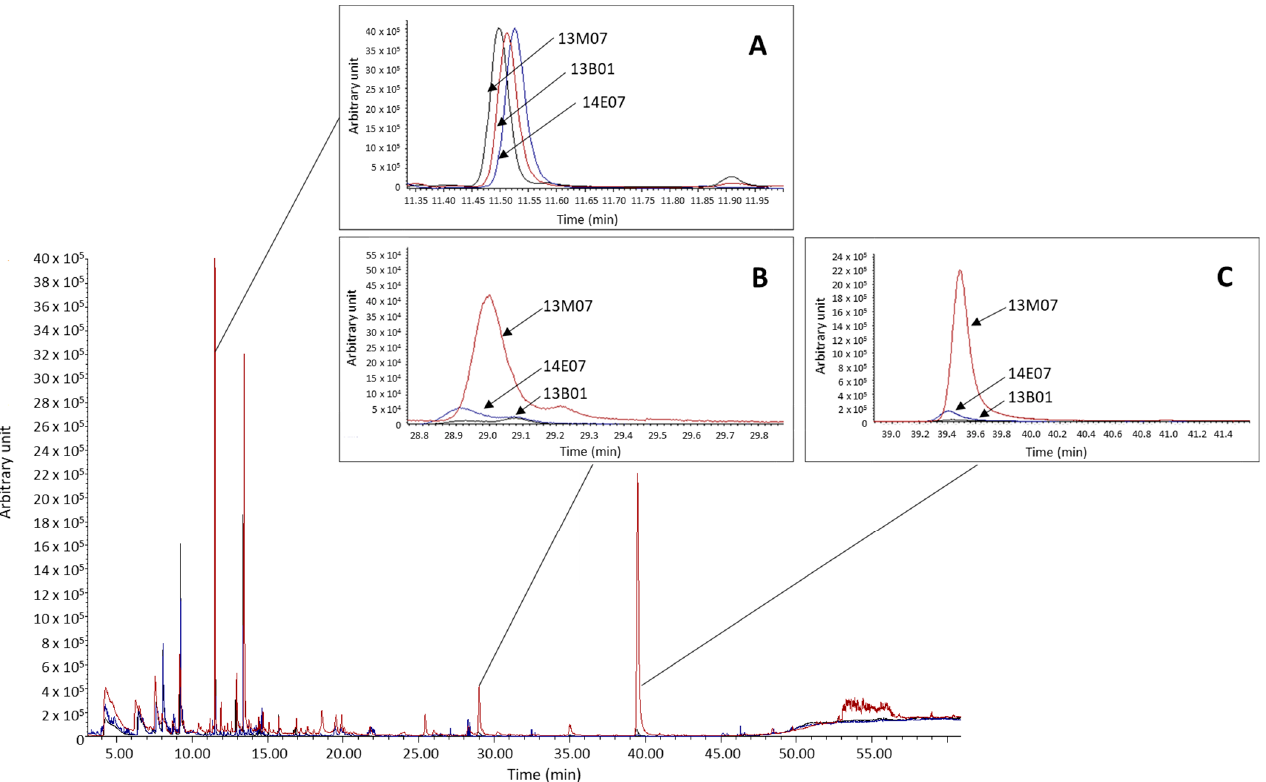
Figure 3. Overlay of chromatograms of each sample and comparison of the abundance of the internal standard ( A ) and the esters methyl benzoate ( B ) and methyl salicylate ( C ), detected in the flowers of the scented hybrids 13M07 and 14E07, and the non-scented 13B01.